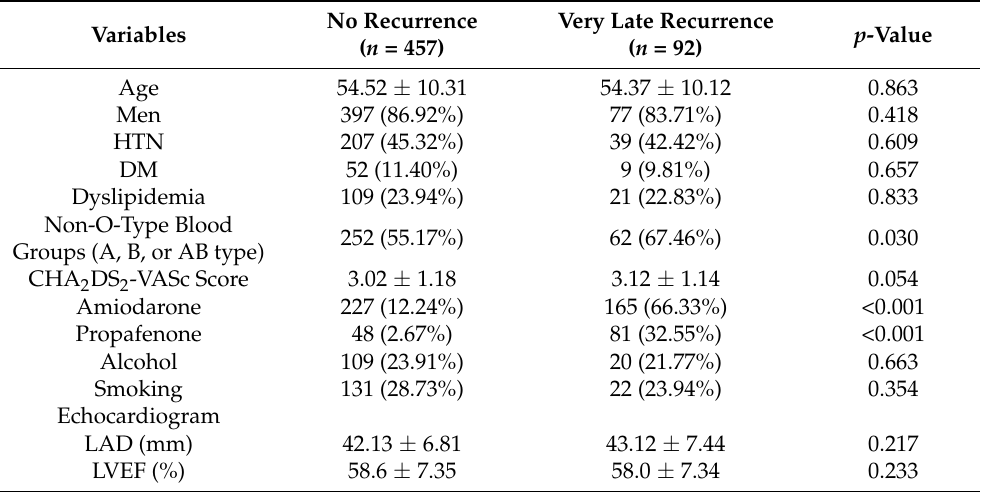
Table 2. Comparison of patient characteristics with or without very late AF recurrence in the non-PAF patients after catheter ablation.